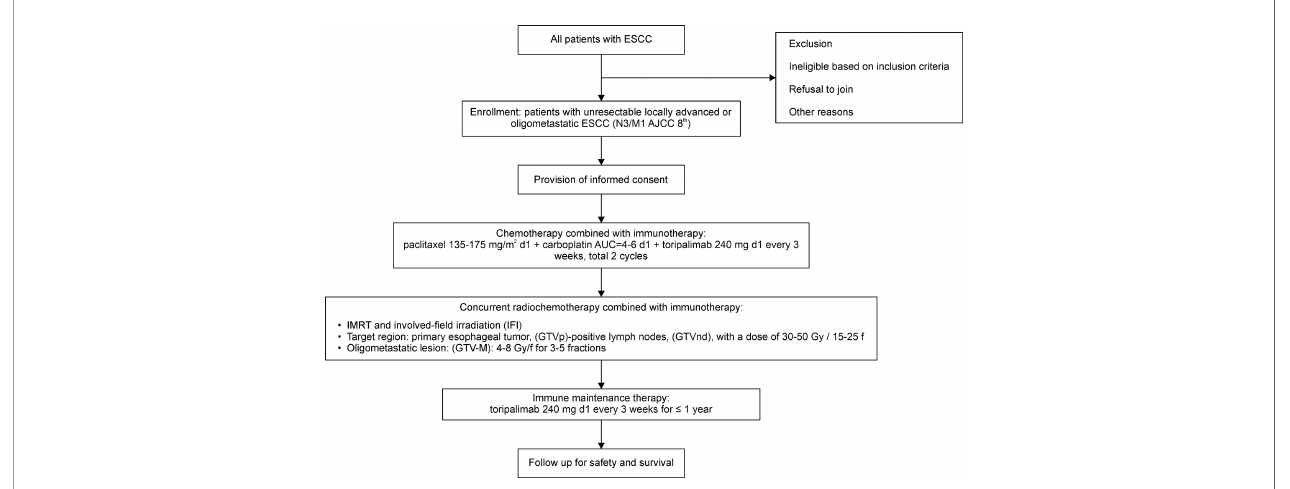
FIGURE 1 | Flowchart of the phase II study. ESCC, esophageal squamous cell carcinoma; AJCC, American Joint Committee on Cancer; d1, day 1; AUC, area under the curve, IMRT, intensity-modulated radiation therapy; GTV-M, gross tumor volume of the primary metastatic lesions; GTV nd , gross tumor volume of lymph nodes; GTV p , primary gross tumor